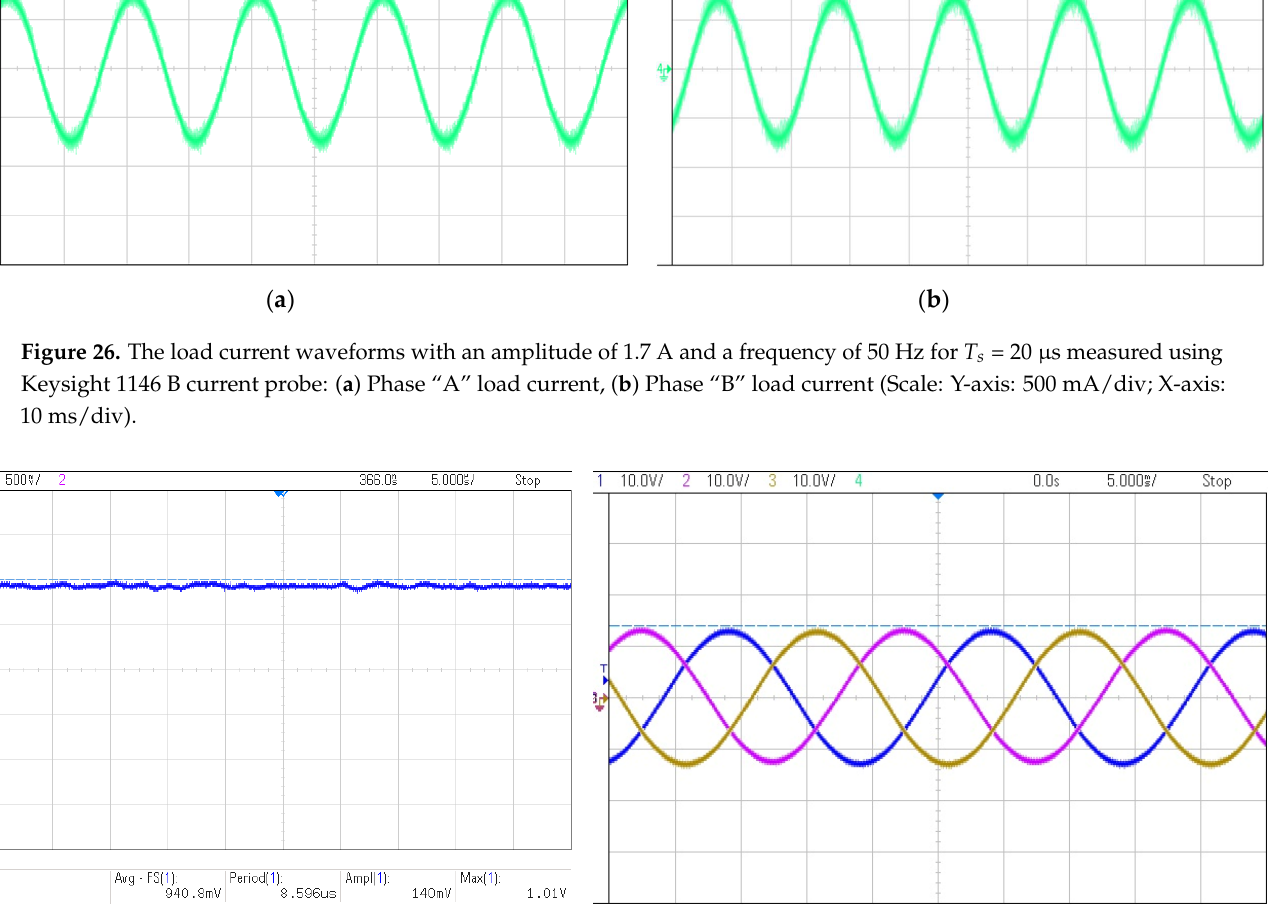
Figure 26. The load current waveforms with an amplitude of 1.7 A and a frequency of 50 Hz for T s = 20 μs measured using Keysight 1146 B current probe: ( a ) Phase “A” load current, ( b ) Phase “B” load current (Scale: Y-axis: 500 mA/div; X-axis: 10 ms/div).